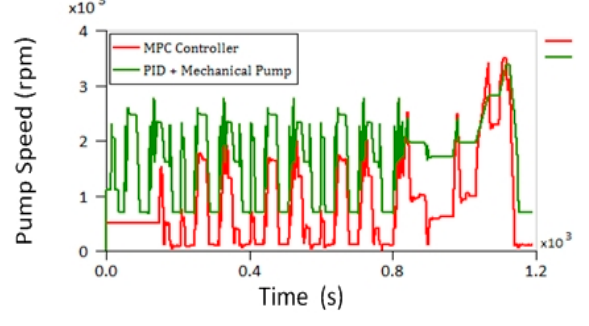
Figure 19. Comparison of pump speed.